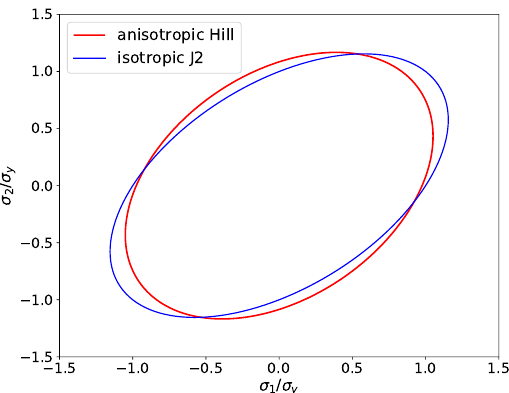
Figure 1. Yield locus for plane-stress conditions ( σ 3 = 0) and Hill-like anisotropy with parameters given in Table 1 (red line) and for an isotropic material with the same yield strength, but H 1 = H 2 = H 3 = 1 (blue line). The values of the principal stresses are normalized by the yield strength σ y